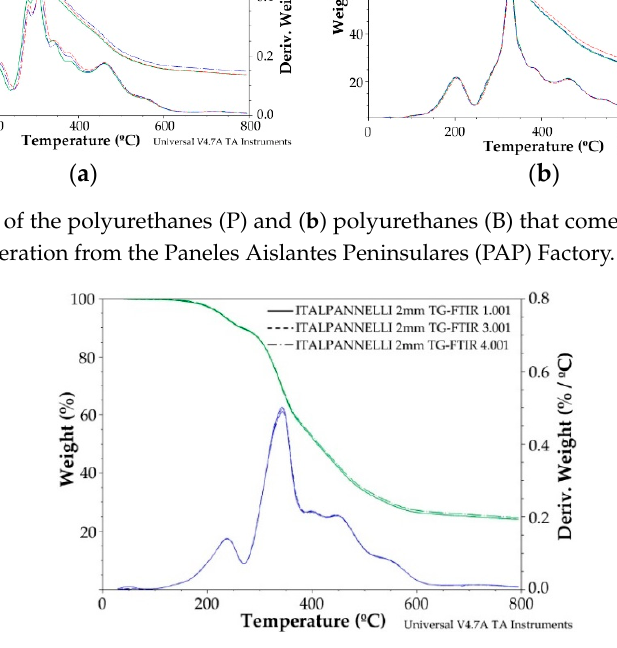
Figure 4. TGA of polyurethane (I) that come from the insulation industry for refrigeration from the Italpannelli factory.